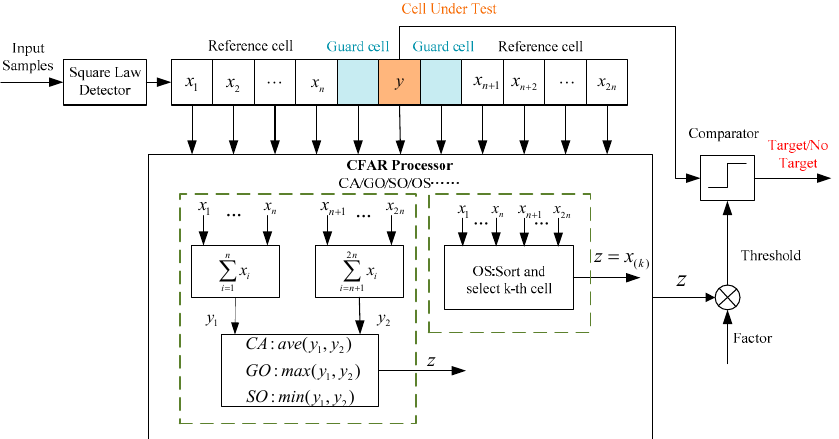
Figure 5. The diagram of typical CFAR detectors. Compared with one ‐ dimensional range detection, two ‐ dimensional detection under phase ‐ coherent accumulation includes range and Doppler detection, which is presented in Figure 6. x denotes the reference cells of range dimension, v denotes the reference cells of the Doppler dimension. The detection process of Doppler dimension is the same as that of range dimension.